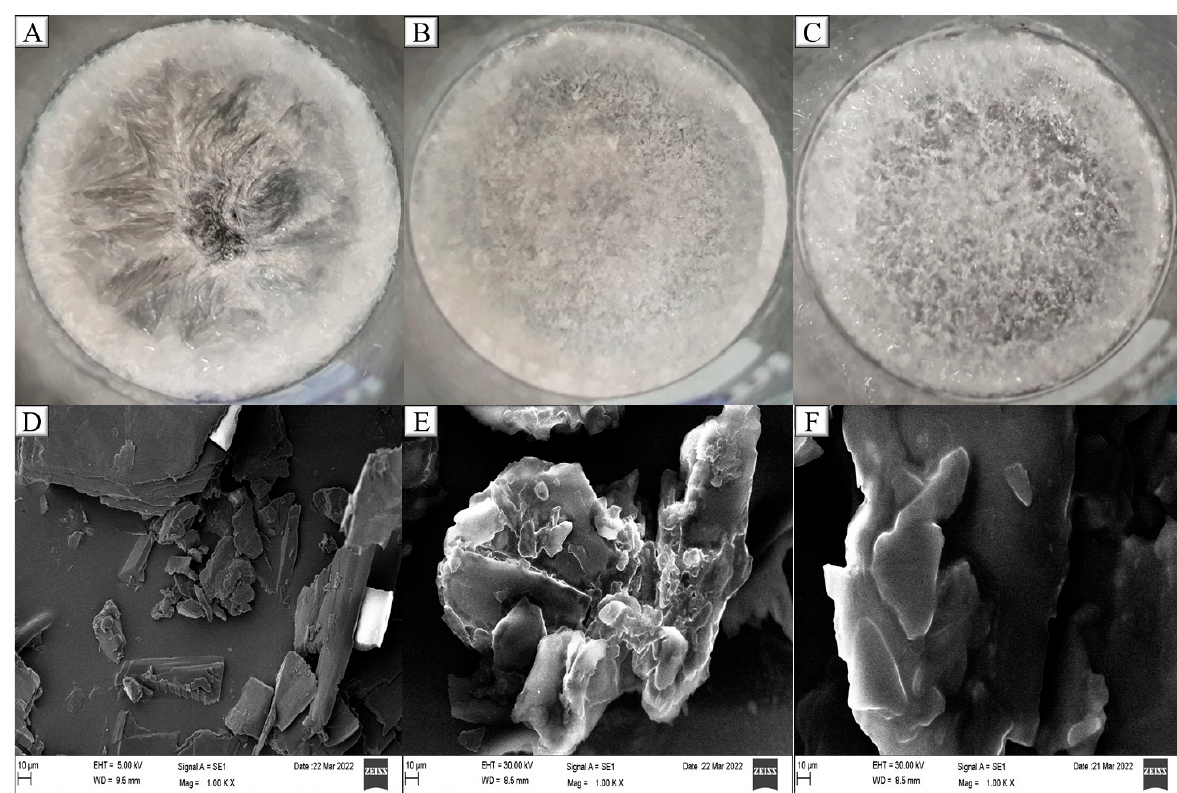
Figure 6. Morphological appearance and SEM image of crushed crystals of ( A , D ) SA, ( B , E ) SA: LCFA (3:1), and ( C , F ) SA:LCT (3:1). The agents were physically mixed and heated to obtain a melted